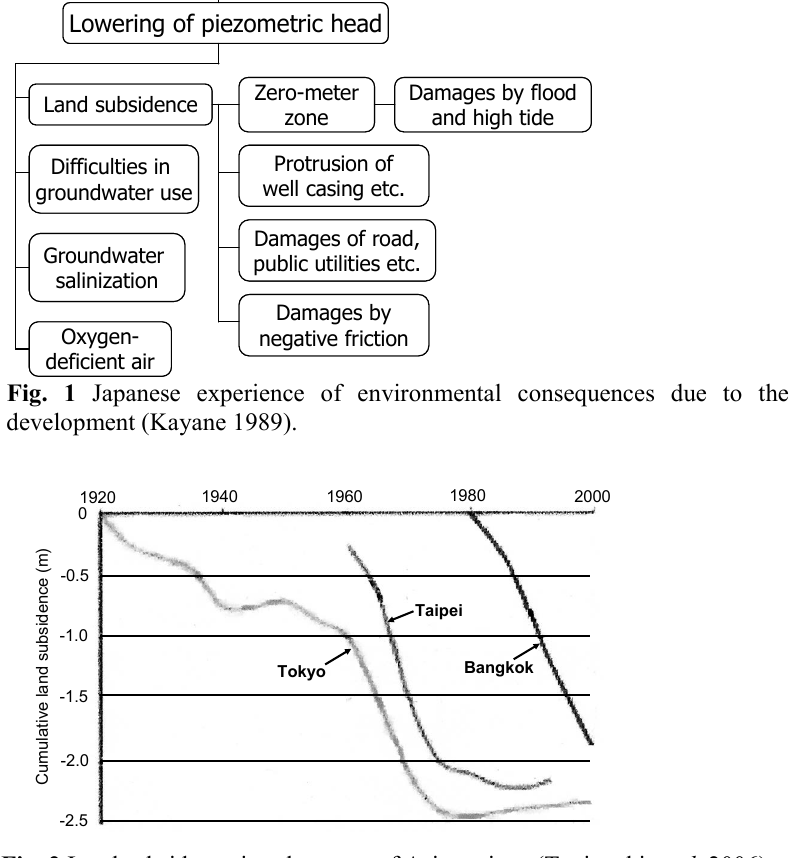
Fig. 2 Land subsidence in urban area of Asia regions (Taniguchi et al .